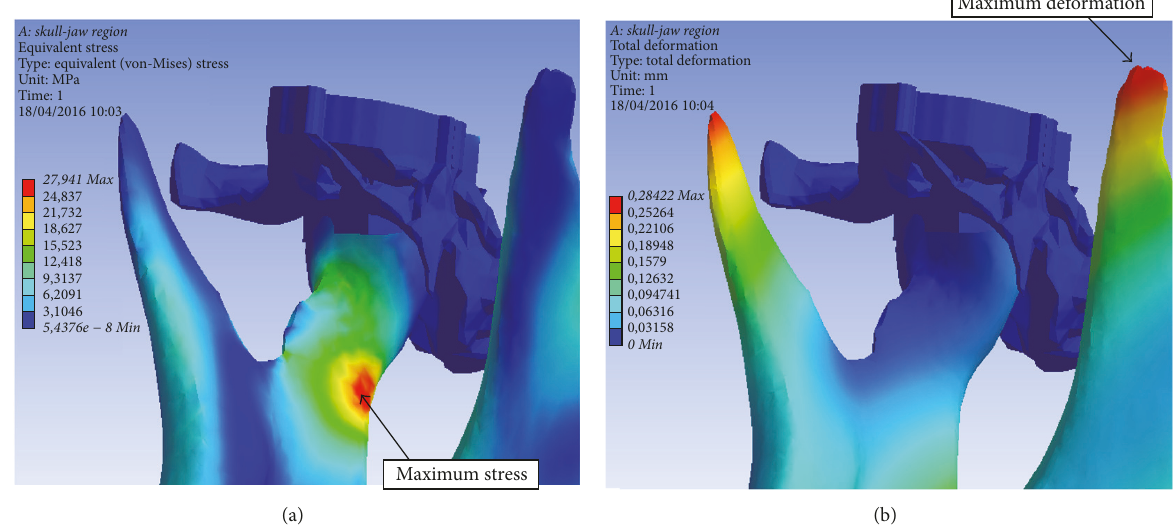
Figure 7: Stress distribution (a) and strain distribution (b) in skull-jaw assembly with elastic articular